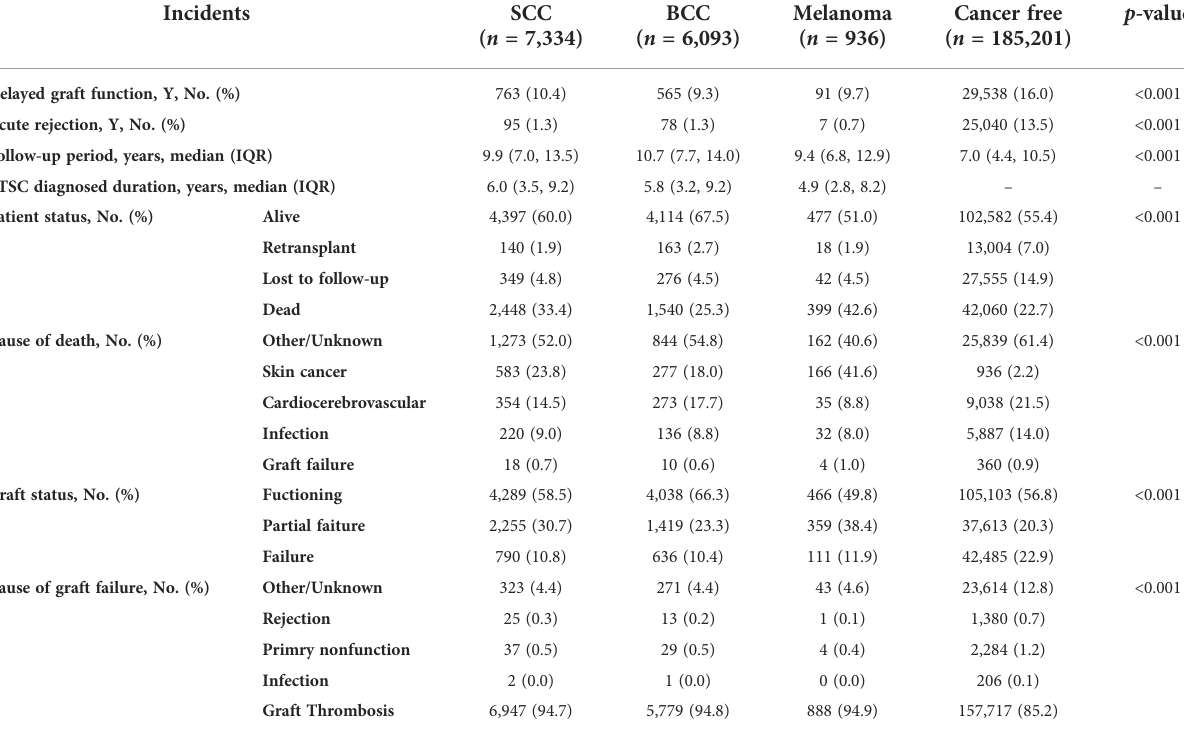
TABLE 2 Recipient status at most follow-ups with cause of death and graft